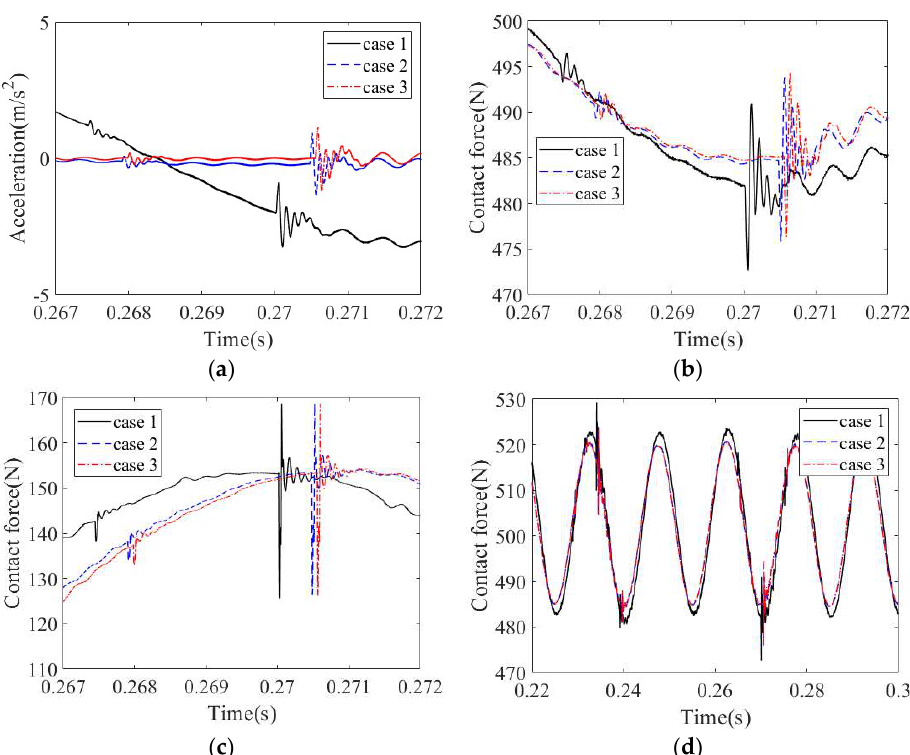
Figure 22. The acceleration signal and forces in the bearing under roller defect and housing stiffness: ( a ) housing acceleration signal from 0.267 s to 0.272 s; ( b ) contact force between outer ring and housing from 0.267 s to 0.272 s; ( c ) contact force between the roller and outer ring from 0.267 s to 0.272 s; ( d ) contact force between outer ring and housing from 0.22 s to 0.3 s.